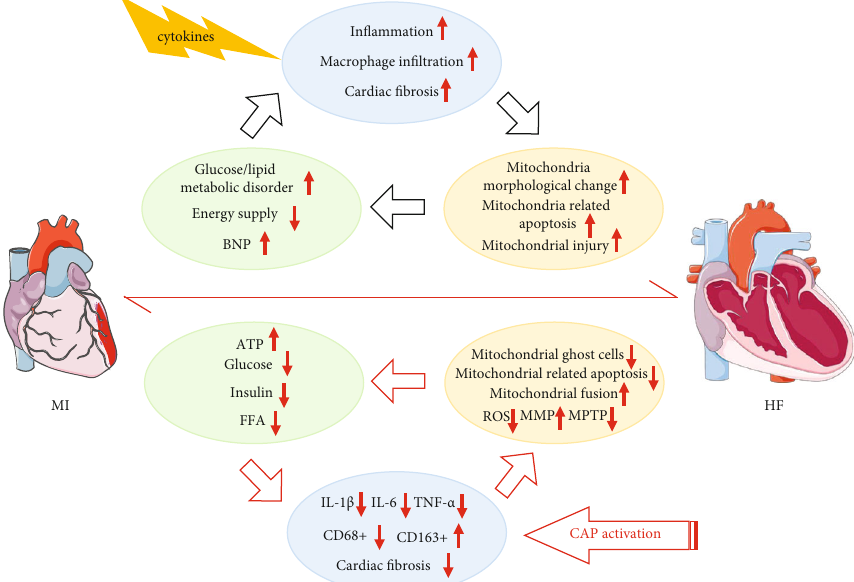
Figure 10: A schematic diagram of the cardioprotection of cholinergic elicitation to heart failure induced by MI. During the period of postinfarction heart advance into heart failure, chronic in fl ammation response induced by initial proin fl ammatory cytokines begets a detrimental pathophysiological circle through disturbing the mitochondrial biogenesis and eventually contributes to the ventricular remodeling. Such aforementioned vicious circle may be partly interrupted by cholinergic